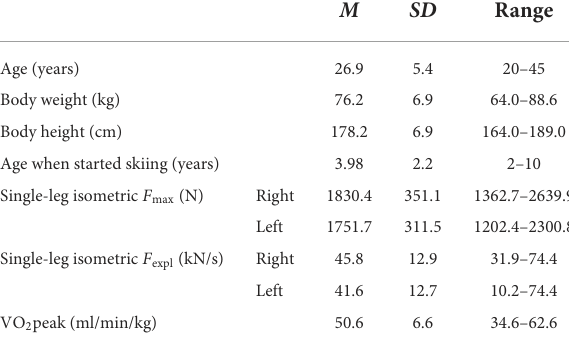
TABLE 1 Sample characteristics ( n =